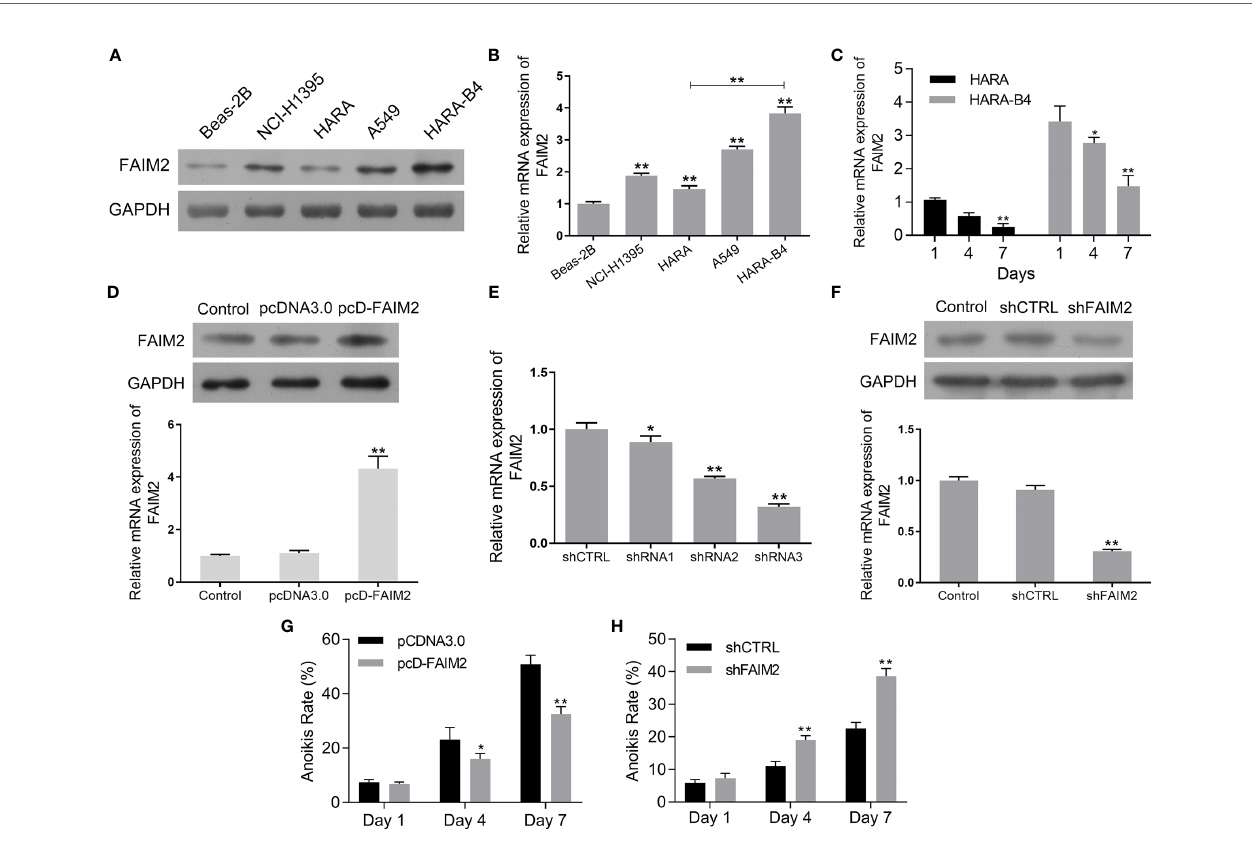
FIGURE 2 | FAIM2 was highly expressed in NSCLC cells and related to cell metastasis. (A, B) FAIM2 protein and mRNA expression in Beas-2B, NCI-H1395, HARA, A549, and HARA-B4 cells was examined by Western blotting and qRT-PCR. (C) qRT-PCR was used to detect FAIM2 mRNA expression in HARA and HARA-B4 cells cultured under anchorage-dependent conditions during day 1 to day 7. (D) Following pcDNA3.0 or pcD-FAIM2 transfection, FAIM2 protein and mRNA expression in HARA cells was examined by Western blotting and qRT-PCR. (E) FAIM2 mRNA expression in HARA-B4 cells transfected with shRNA1, shRNA2, or shRNA3 was examined by qRT-PCR. (F) FAIM2 protein and mRNA expression in HARA cells transfected with shCTRL or sh-FAIM2 was examined by Western blotting and qRT-PCR. (G) Following transfection with pcDNA3.0 or pcD-FAIM2, HARA cell anoikis due to a loss of adherence for 1, 4, and 7 days was detected. (H) Following transfection with shCTRL or sh-FAIM2, HARA-B4 cell anoikis due to a loss of adherence for 1, 4, and 7 days was detected. P < 0.05, *; P < 0.01, ** vs. Beas-2B, Day1, the pcDNA3.0 or shCTRL